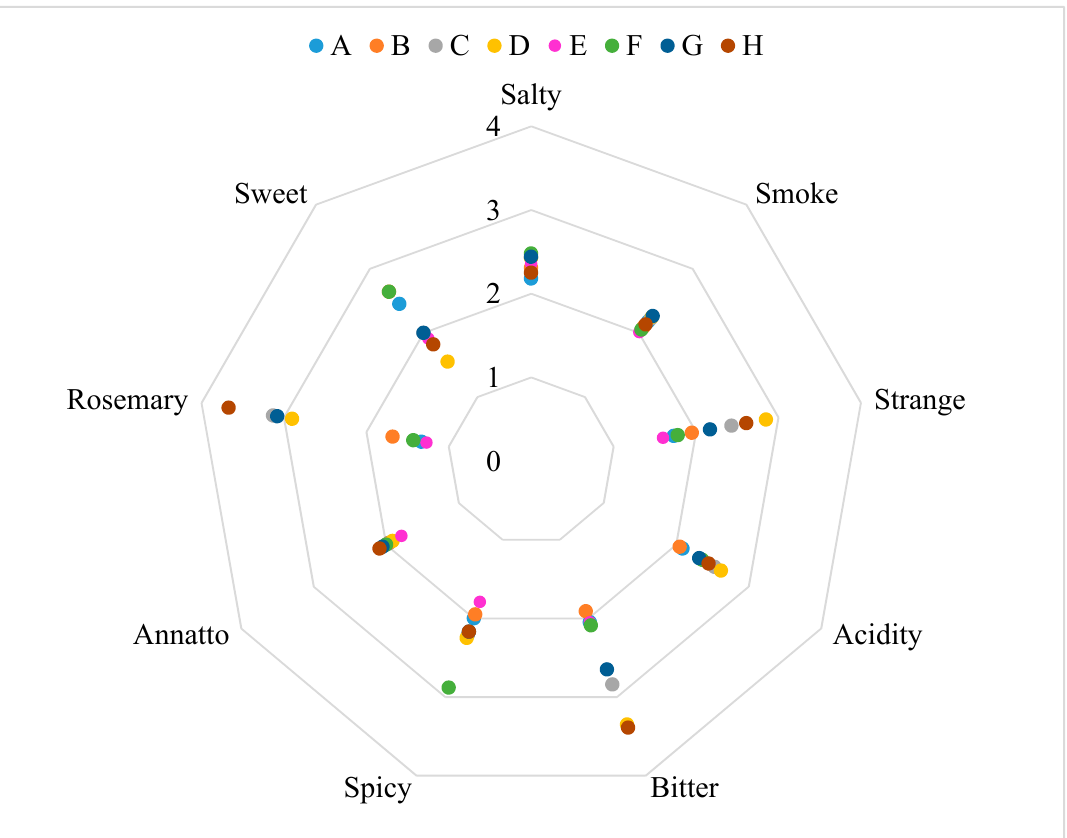
Figure 5. Results of the sensory analysis for taste descriptors. A: Salami slice packaged with the control film during a 90-days storage period evaluated without the packaged; B: Salami slice packaged with the control film during a 90-days storage period evaluated with the packaged; C: Salami slice packaged with the active film during a 90-days storage period evaluated without the packaged; D: Salami slice packaged with the active film during a 90-days storage period evaluated with the packaged; E: Salami slice packaged with the control film during a 30-days storage period evaluated without the packaged; F: Salami slice packaged with the control film during a 30-days storage period evaluated with the packaged; G: Salami slice packaged with the active film during a 30-days storage period evaluated without the packaged; H: Salami slice packaged with the active film during a 30-days storage period evaluated with the packaged.